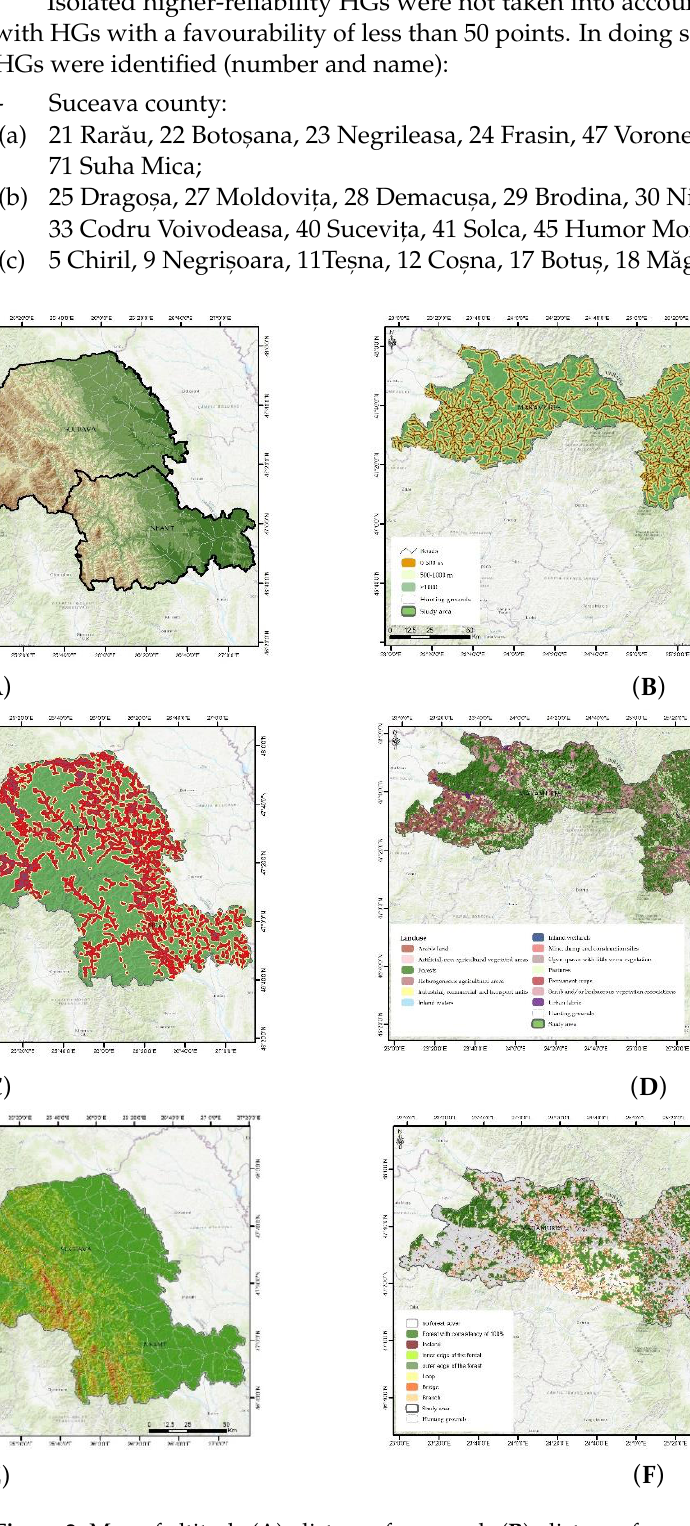
Figure 2. Map of altitude ( A ), distance from roads ( B ), distance from settlements ( C ), land use ( D ), slope ( E ), and the connectivity categories for the forest ( F ).